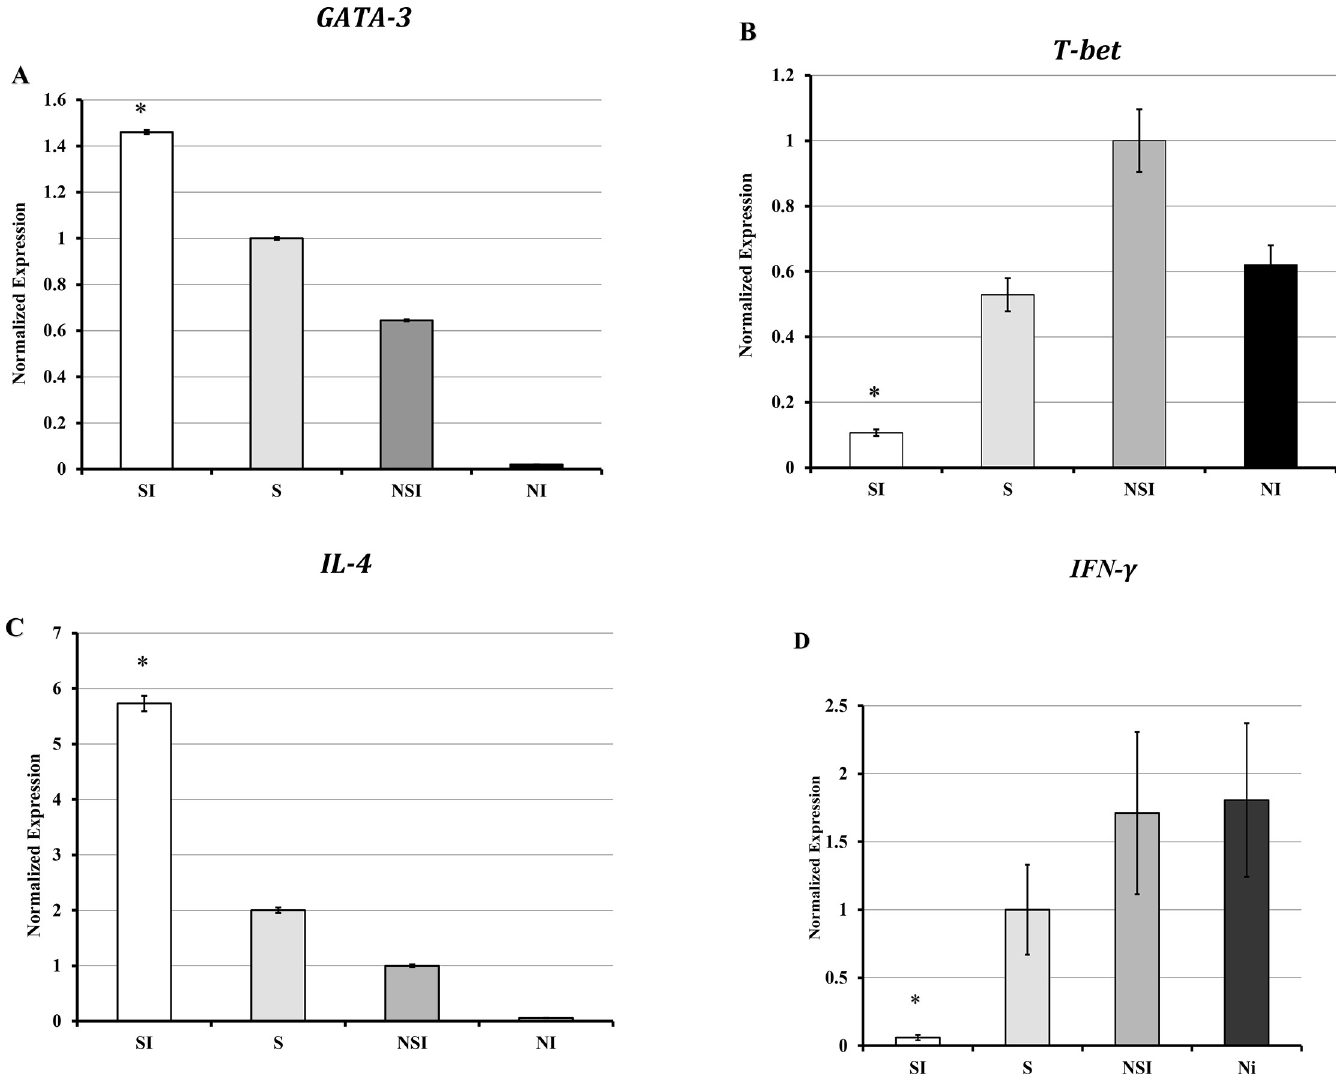
Fig 4. Fold-changes of gene expression of transcription factors and signature cytokines of Th1 or Th2. A ) GATA-3, B ) T-bet, C ) IL-4) and D ) IFN- γ in na ï ve CD4 + T cells isolated from spleen cells normalized to the internal control gene, GAPDH compared to the non-stressed mice are shown. Data shown a mean +/_ SEM of two or more independent experiments ran on different dates. � Denotes significant statistical differences between treatment groups at the level of (p <